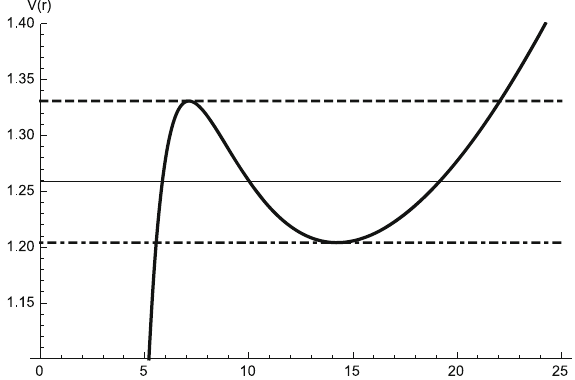
Fig. 3 The behavior of V ( r ) for non-radial particles ( L = 10) as a function of r , with M = 2, z = 100, and m p = 1. The dashed line corresponds to E = E u ≈ 1 . 331, the dot dashed line corresponds to E = E s ≈ 1 . 204 and the thin line corresponds to E = 1 .